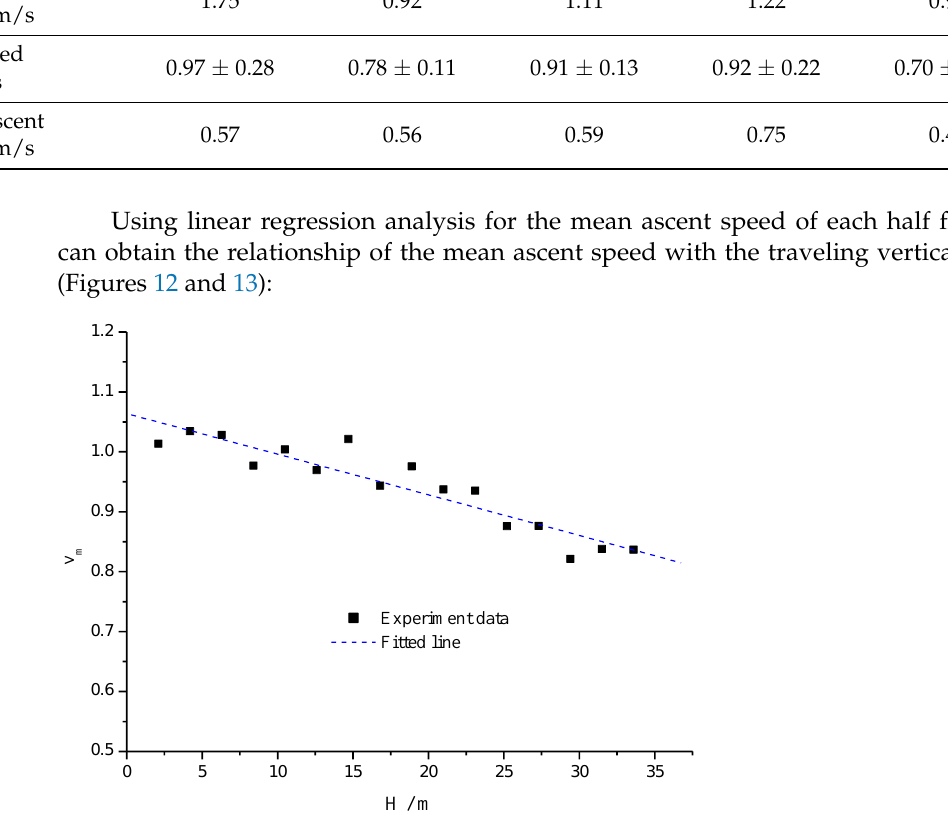
Figure 12. Variation in the mean ascent speed of males with vertical height.